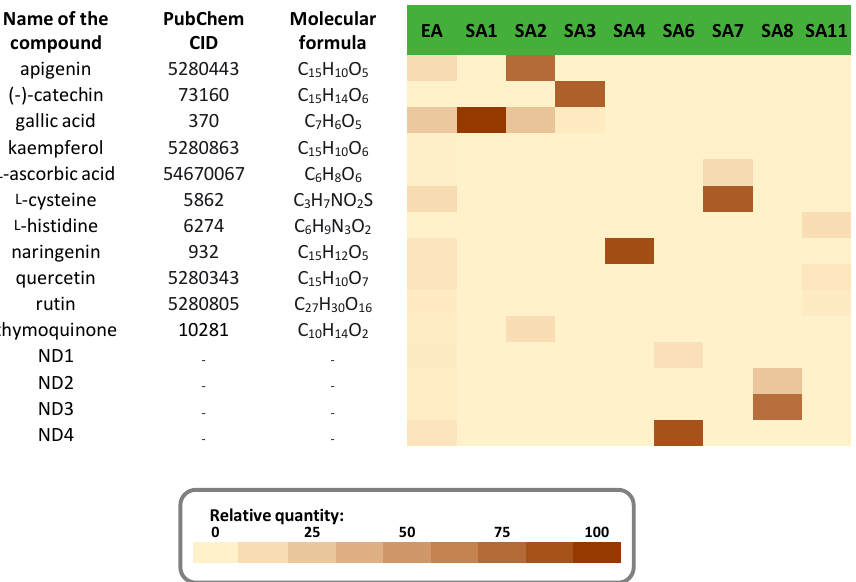
Figure 3. Relative abundance (in % of total peak area) of the main components of the N. sativa seeds acetone extract (EA) and its resulting acetone fractions (SA1–SA11) determined by HPLC–DAD analysis. HPLC–DAD chromatograms are shown in Figure S2. UV spectra are shown in Figure S3. Values are given in Table S2.